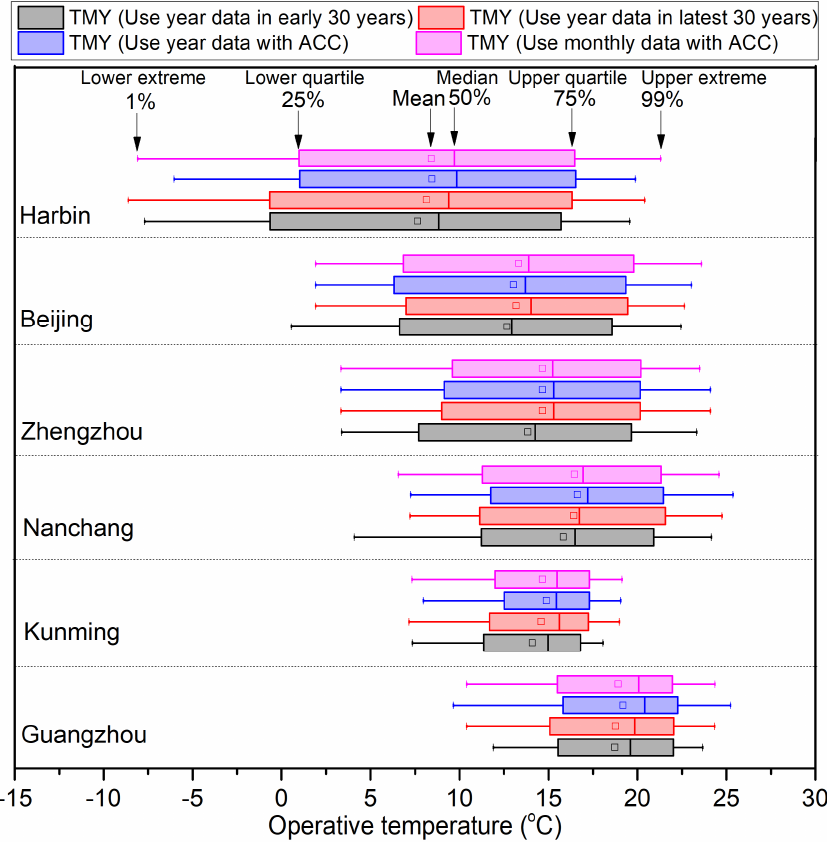
Figure 10. Adaptive thermal comfort temperatures of six selected cities in